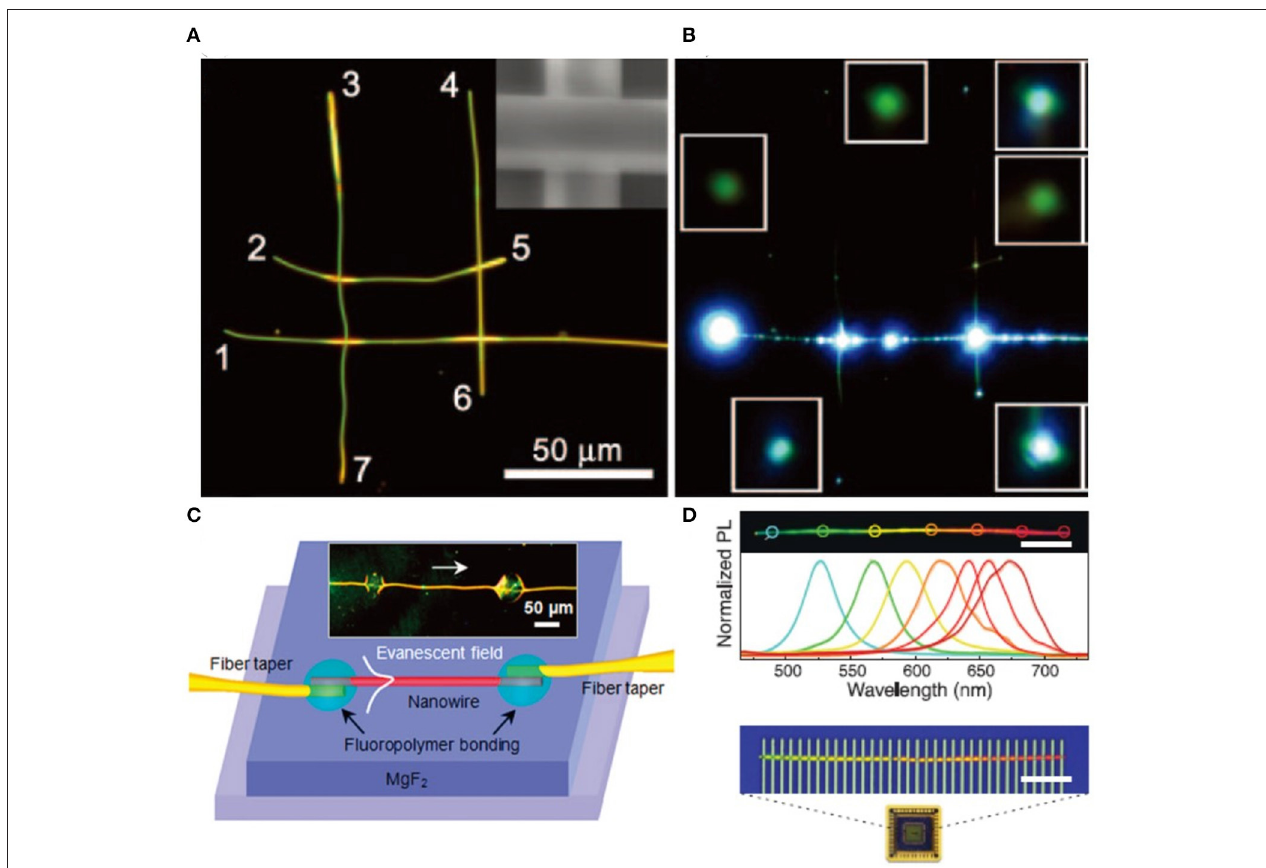
FIGURE 15 | (A) Dark-field image of the four-ribbon structure. Light is inputted from the right long side and the output channels are labeled as 1–7. Scale bar: 50 µ m. (B) PL image as the input channel is pumped at 325nm. (C) Schematic illustration of the polymer nanowire sensor. Scale bar: 50 µ m. (D) Real-color PL image of a typical compositionally graded CdS x Se 1 − x nanowire and corresponding spectra collected from marked representative regions (spot size ∼ 5 µ m). Scale bar: 20 µ m. (A,B) Reproduced with permission. Sirbuly et al. (2005) Copyright 2005, National Academy of Sciences. (C) Reproduced with permission. Gu et al. (2008) Copyright 2008, American Chemical Society. (D) Reproduced with permission. Yang Z. et al. (2019) Copyright 2020, American Association for the Advancement of